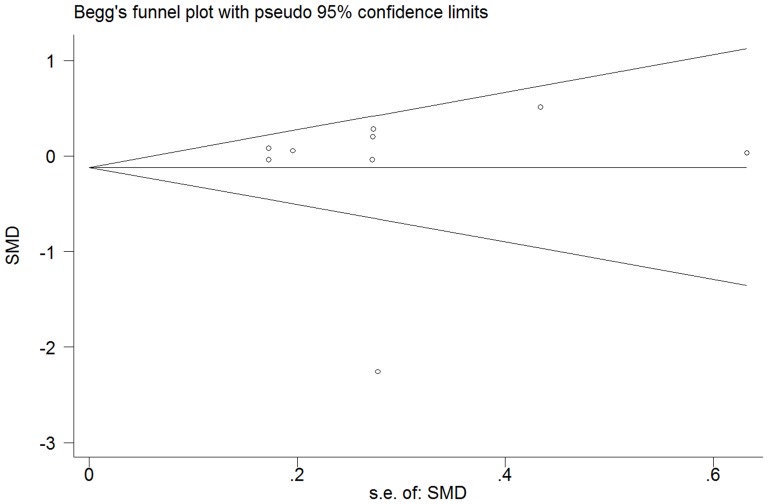
Publication bias.